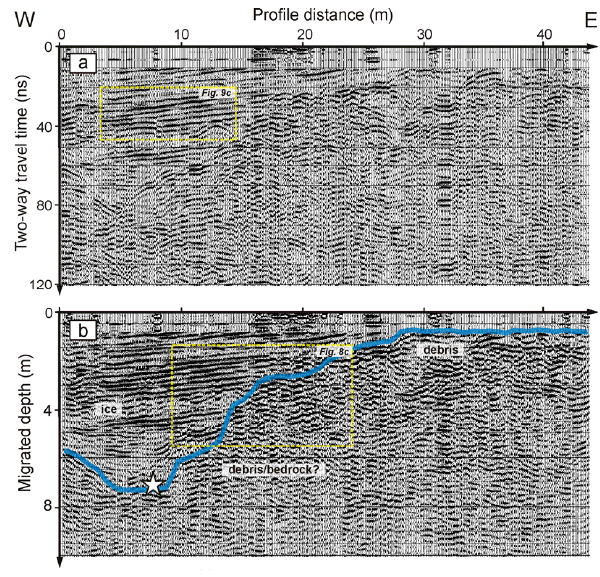
Figure 6: Radargram section (a) from Eisriesenwelt. Note the strong layering in within the ice in the first half of the profile. The blue line in the migrated section (b) shows the interpreted Fig. 6. Radargram section (a) from Eisriesenwelt. Note the strong base. The white star denotes the maximum ice depth (7.12 m) from the core drilling reported layering in within the ice in the first half of the profile. The blue in May et al. (2010). Note that the inclination of the internal layers does not follow the base line in the migrated section (b) shows the interpreted base. The topography. white star denotes the maximum ice depth (7.12m) from the core drilling reported in May et al. (2011). Note that the inclination of the internal layers does not follow the base